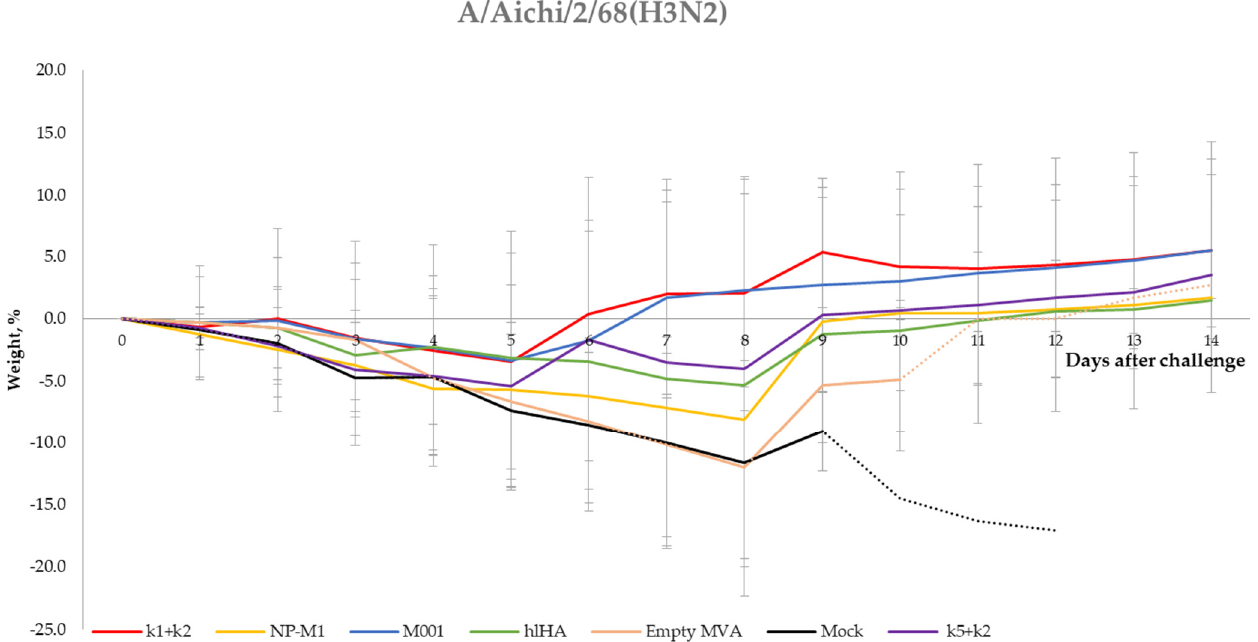
Figure A2. Loss of body weight of mice immunized with rMVAs expressing influenza virus antigens or with wt MVA or PBS after virus challenge with the H3N2 subtype virus strain A/Aichi/2/68. The dotted line indicates that there are less than four mice.